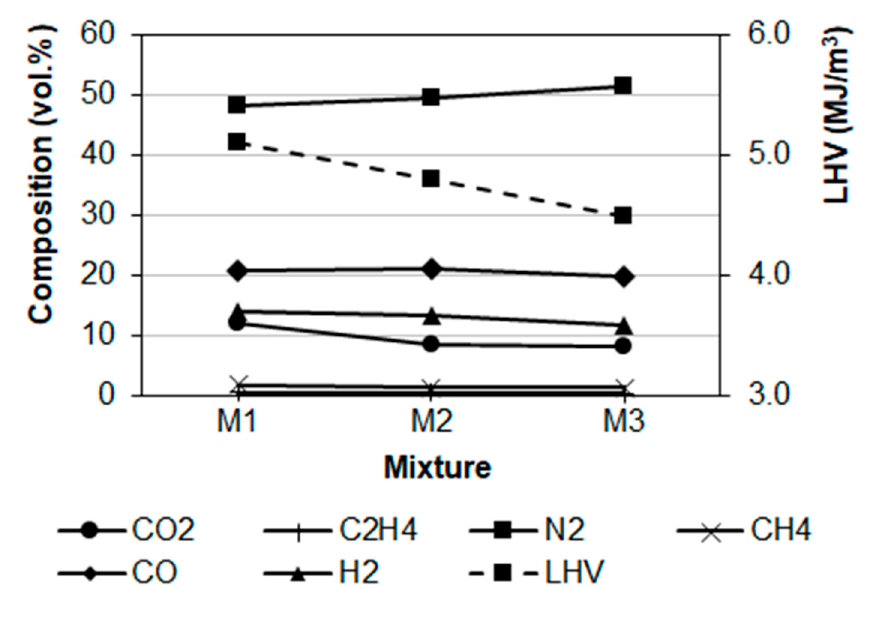
Figure 2. Composition and LHV of gas samples from the various